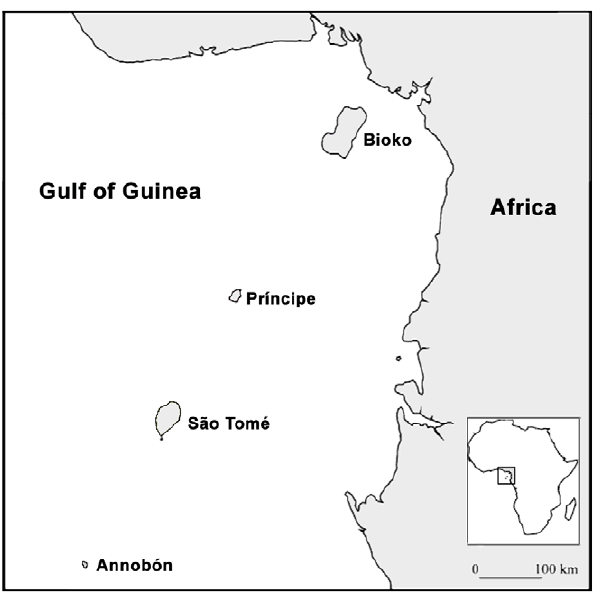
Figure 1. Map of the Gulf of Guinea islands indicating the location of